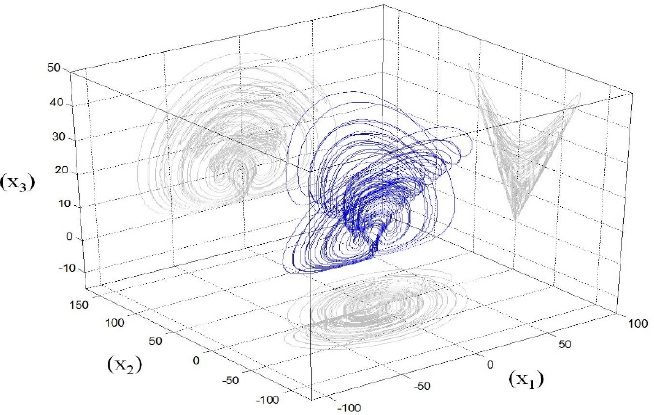
Figure 1. A comprehensive reveal: 3-D phase portrait and its 3-axis projections of the four-dimensional Chen–Lee system.